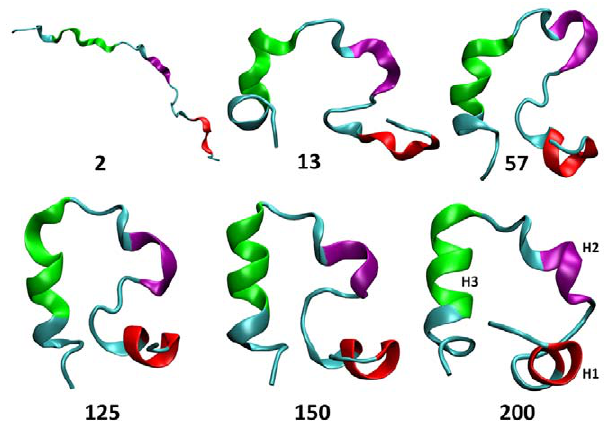
Figure 4. Some sampled conformations on the folding trajectory. Numbers indicate the folding step. H1 (red), H2 (purple) and H3 (green) denote the three helices of Villin headpiece.